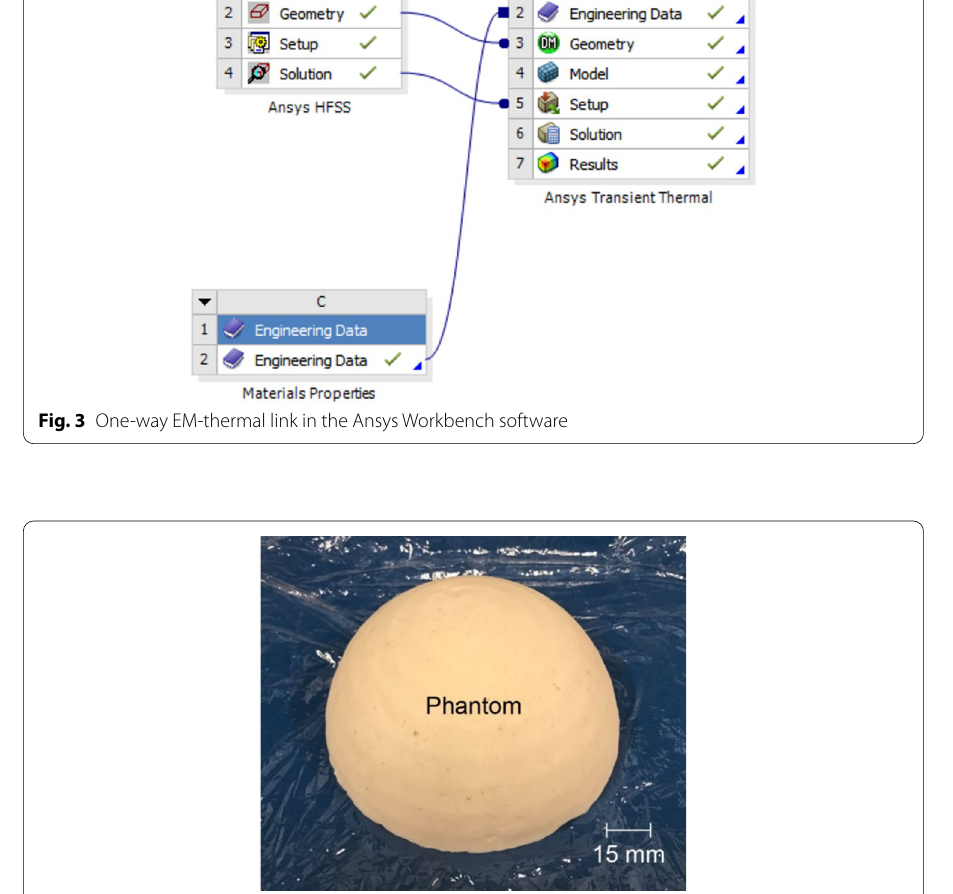
Fig. 4 Breast phantom